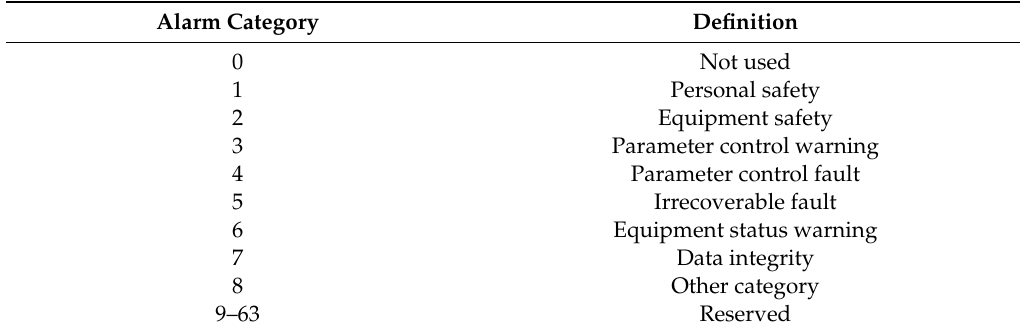
Table 2. Alarm category